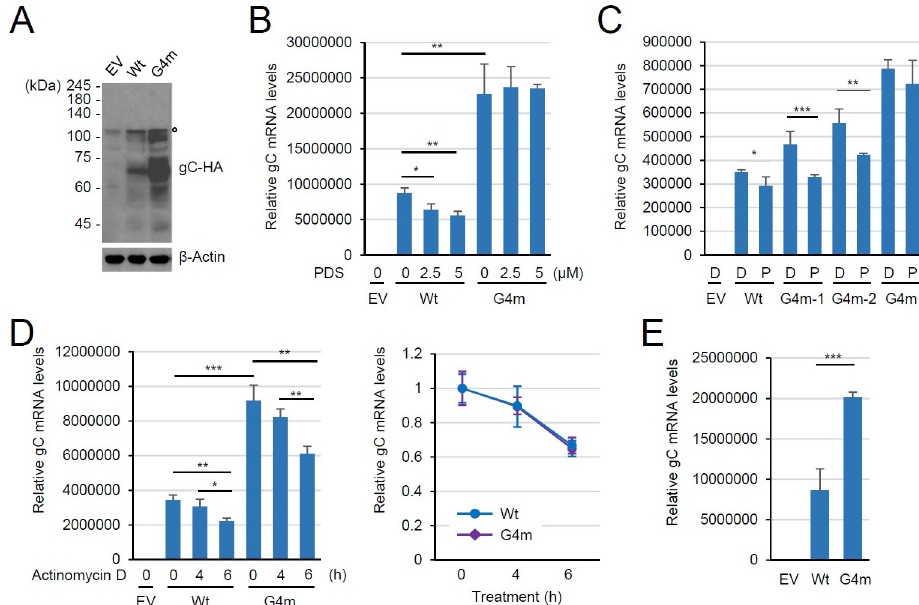
Fig 7. Effect of G4 disruption in ORF14 on gC expression in transfected cells. (A) 293T cells (1x10 6 cells per well) in six-well plates were transfected with 2 μ g of empty vector (EV) or plasmids expressing pOka ORF14-HA or its G4-disrupted form (G4m). Total cell lysates were prepared in RIPA buffer at 72 h after transfection. The total cell lysates were subjected to immunoblotting with anti-HA antibody. Non-specific bands are indicated by the open circle. The levels of β -actin are shown as a loading control. (B) 293T cells were transfected as in (A) and treated with DW or increasing amounts (2.5 and 5 μ M) of PDS at 16 h after transfection. At 72 h after transfection, total RNA was prepared and the ORF14 mRNA levels were measured by qRT-PCR and normalized with those of β -actin. Results are shown as mean values and standard errors of triplicates. (C) 293T cells (1x10 6 cells per well) in six-well plates were transfected with 2 μ g of empty vector (EV) or plasmids expressing wild-type ORF14-HA (Wt) or its different G4-mutated forms (G4m-1, G4m-2, or G4m) and treated with DW (D) or 2.5 μ M of PDS (P) at 16 h after transfection. At 72 h after transfection, total RNA was prepared and the ORF14 mRNA levels were measured by qRT-PCR as in (B). (D) 293T cells were transfected as in (A) and treated with actinomycin D for the indicated times. The gC mRNA levels were determined as in (B and C). (E) 293T cells were transfected with 2 μ g of empty vector (EV) or plasmids expressing pOka ORF14 (Wt) or its G4-disrupted form (G4m). The gC mRNA levels were determined as in (B) and (C).